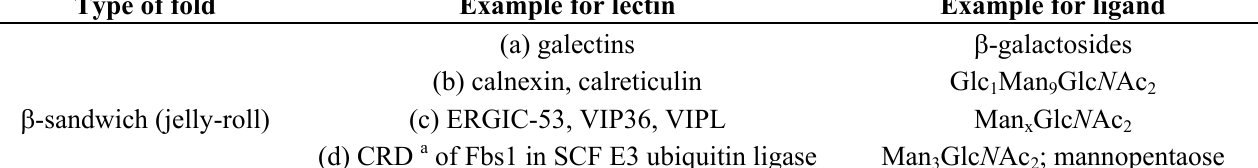
Table 1. Overview of folds with capacity to bind sugars and of lectin